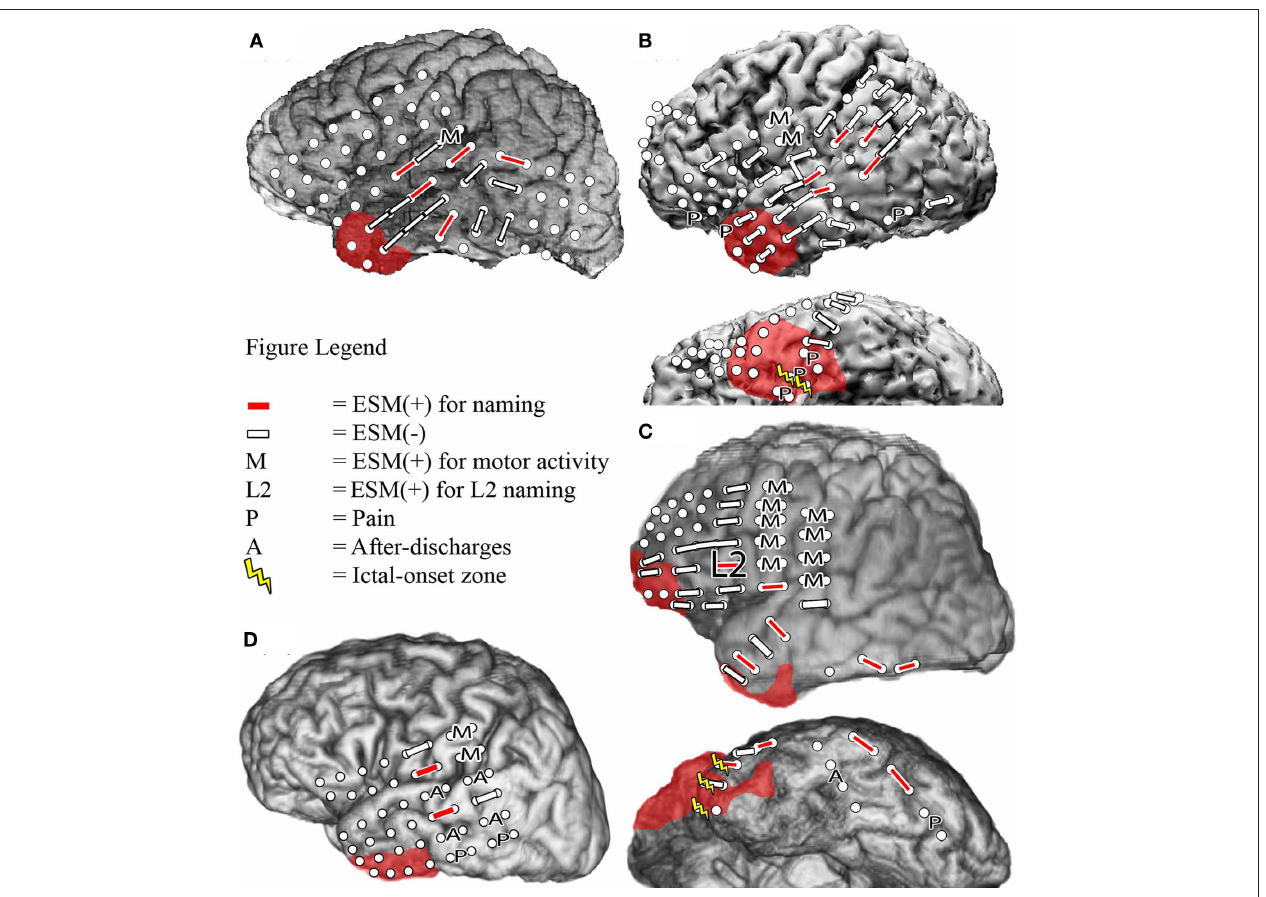
applicable. White circles indicate the locations of the implanted subdural electrodes. In Patients 1 and 4, the ictal-onset zone was in the left mesial temporal region and is not depicted. Areas with red shading indicate the resection boundaries. No basal temporal ESM was performed in these patients, so basal views are not